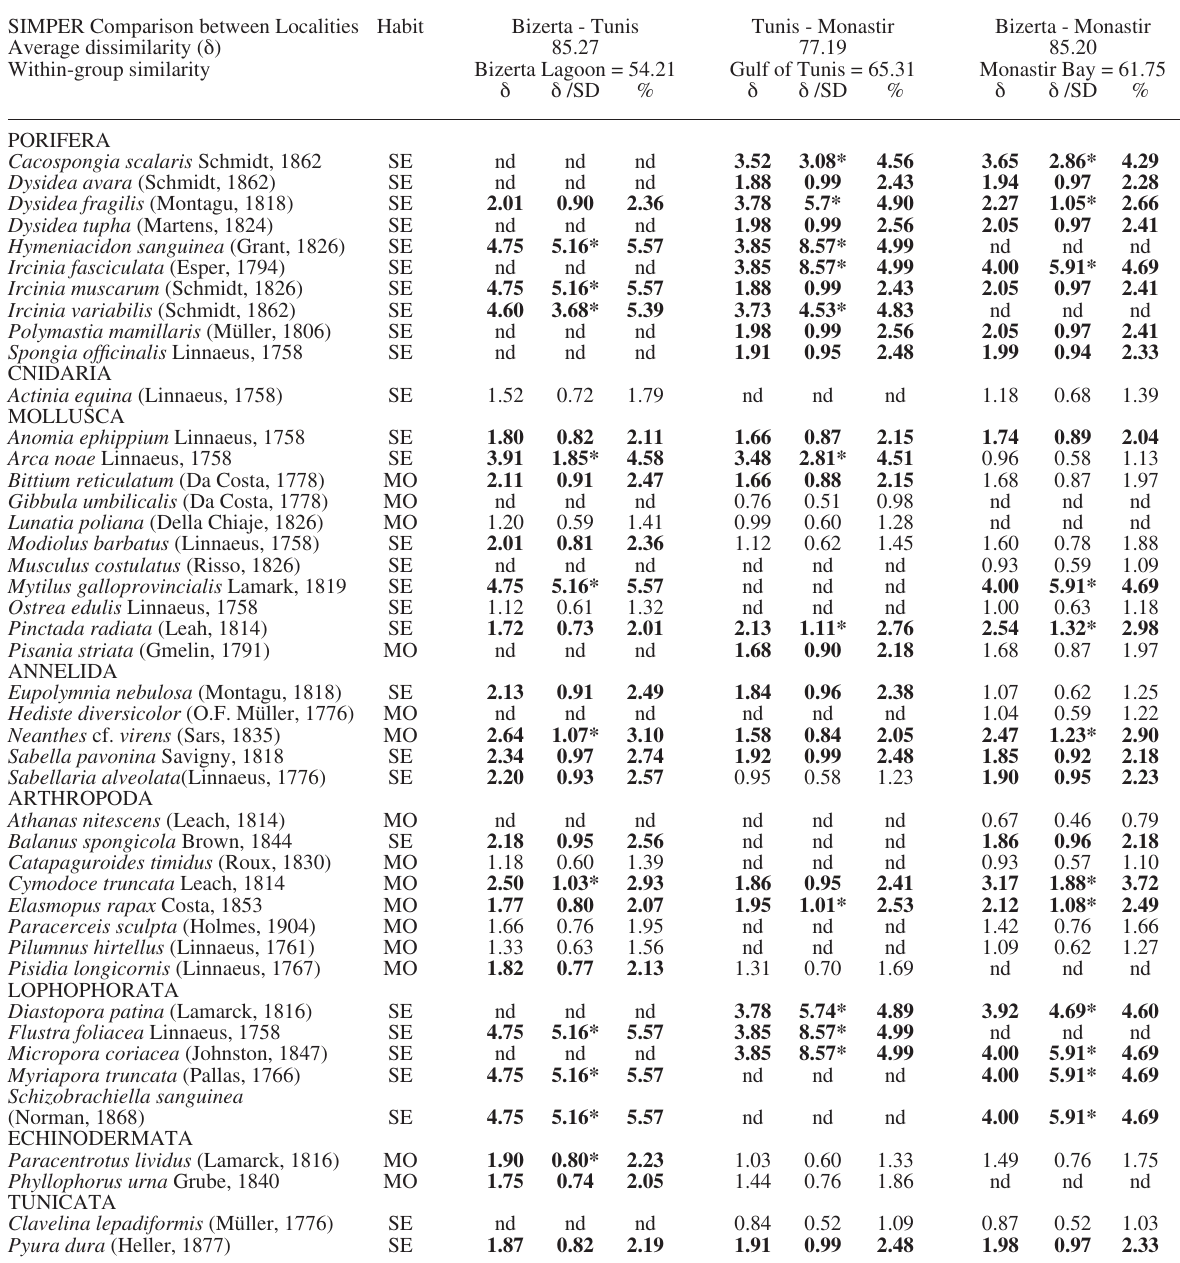
Table 4. – dissimilarity percentage analysis of the epifaunal communities living on Pinna nobilis at three different localities. Sixty-five out of 146 species (at least 3% of species abundance per sample) are considered; cut-off for low contributions 90%. Bold face names indicate the most contributing species in among-locality comparisons ( δ ). Asterisk on δ /Sd ratio indicates the most significant species for discriminating the different localities in terms of δ % (nd, not detectable value). habit (Se, sessile; mo, motile) and constancy index is also reported for